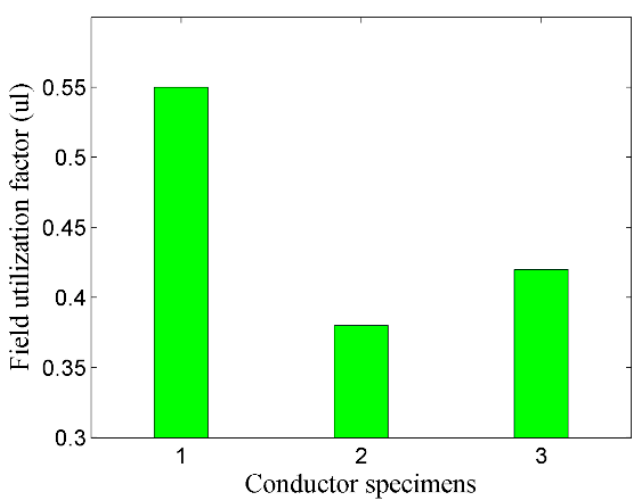
Figure 7. Field utilization factor comparison regarding the different conductor specimens described in Table 2.